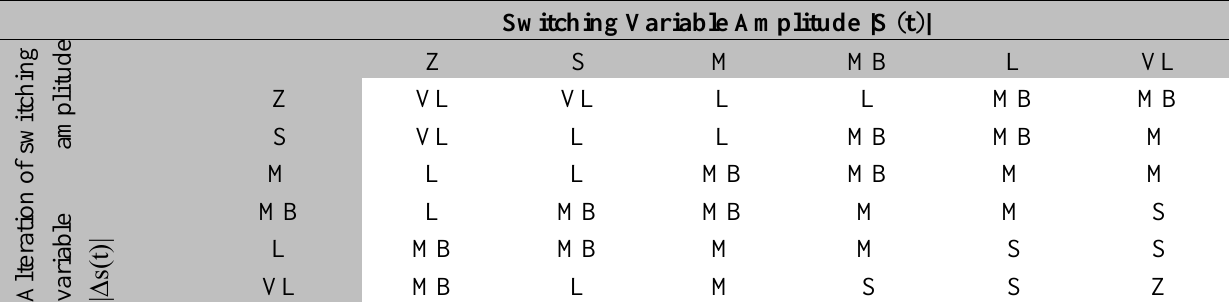
Table 1. Fuzzy rule based matrix for